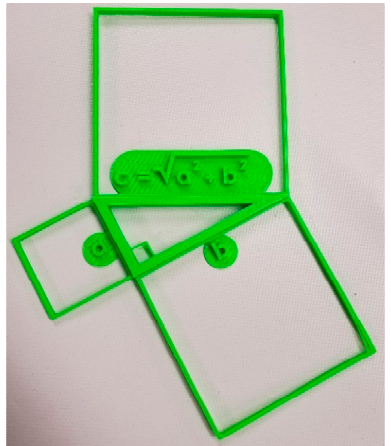
Figure 2. Pythagorean theorem model [67].